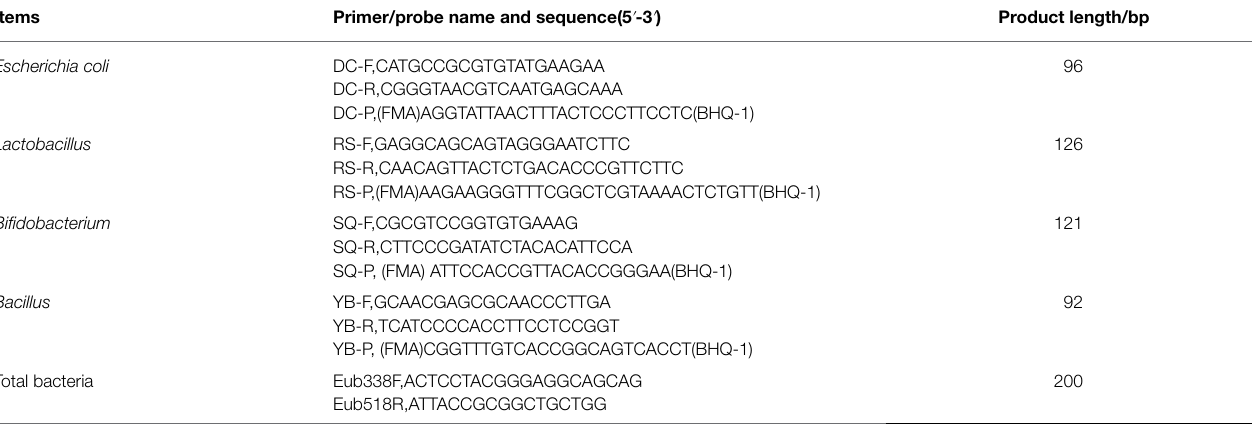
TABLE 3 | Primes and probes for real-time PCR of